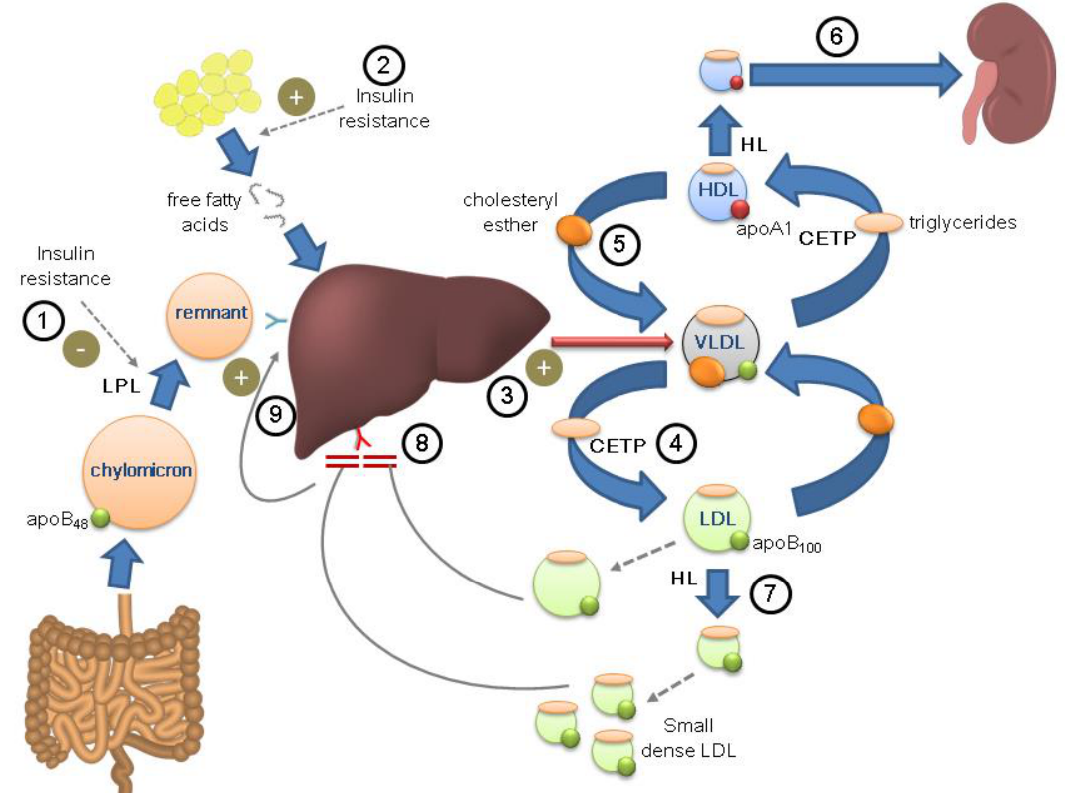
Figure 1. Potential combination of the physiopathological mechanisms of diabetes and familial hypercholesterolemia in the same individual. Diabetic dyslipidemia. Insulin resistance reduces lipoprotein lipase activity (LPL) ① , decreasing plasma triglyceride clearance, and promotes the release of free fatty acids ② , which are taken up by the liver and used for the synthesis and release of VLDL ③ . VLDL exchange triglycerides and cholesterol esters with LDL ④ and HDL ⑤ through the action of cholesteryl ester transfer protein (CETP). Triglyceride-rich HDL particles, through the action of hepatic lipase (HL), are converted into smaller particles, with less anti-atherogenic properties, which are cleared more rapidly in the kidney ⑥ . LDL particles also become smaller and denser (LDL phenotype B), more pro-atherogenic ⑦ . Familial hypercholesterolemia. The genetic defect in LDL receptor prevents its uptake and metabolism in the liver, favoring the accumulation of LDL particles ⑧ . This generates an increase in the uptake of chylomicrons and remnants in the liver ⑨ , in turn boosting the synthesis of VLDL.